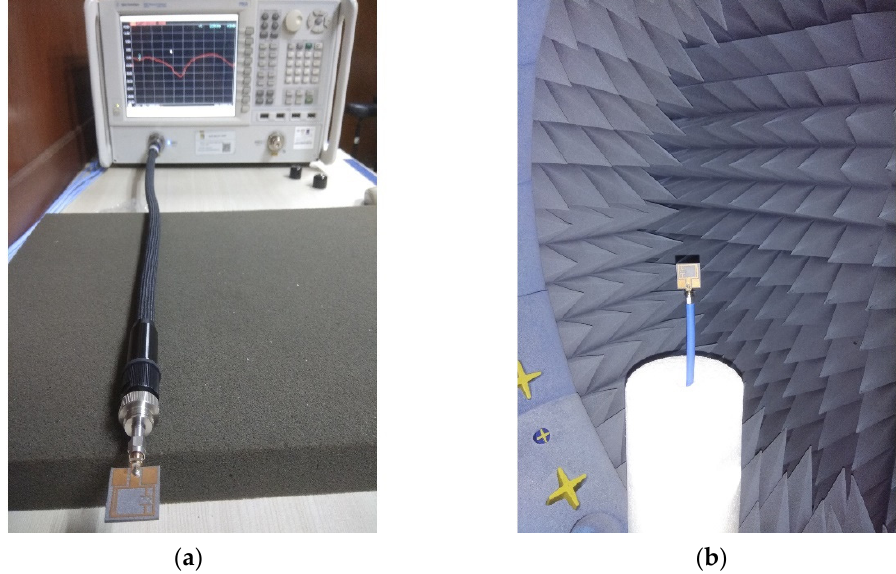
Figure 13. Measurement setup of ( a ) PNA and ( b ) Satimo Star Lab.